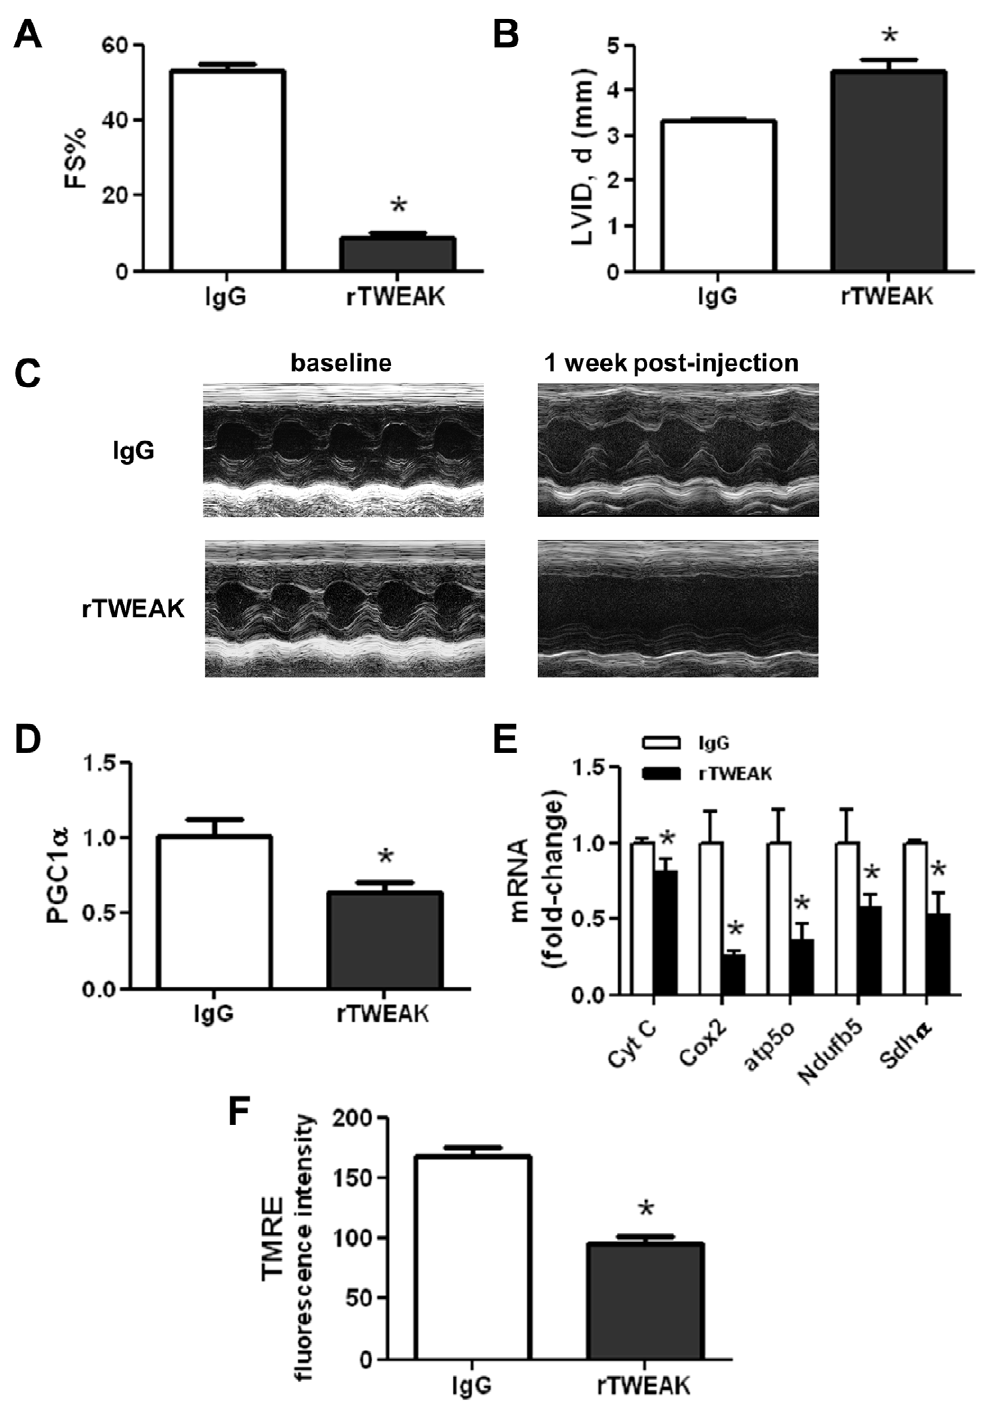
Figure 2. rTWEAK delivery results in cardiomyopathy and altered metabolic gene expression. (A) Fractional shortening (FS%) and (B) Left ventricular diastolic chamber dimension (LVID), as determined by transthoracic echocardiography in mice one week after intravenous delivery of IgG or rTWEAK. (C) Representative M-Mode echocardiographic images before and following IgG or rTWEAK injection in mice. Real time PCR analysis of heart samples for expression of (D) PGCl a and (E) OXPHOS genes, normalized to b -actin and presented relative to the IgG group. (F) Mitochondria membrane potential in IgG and rTWEAK treated cardiomyocytes. The membrane potential was measured by TMRE staining. The fluorescent intensities of TMRE were normalized to the total number of cardiomyocytes in the respective fields. * p , 0.05 vs. IgG, N=3 for each group.